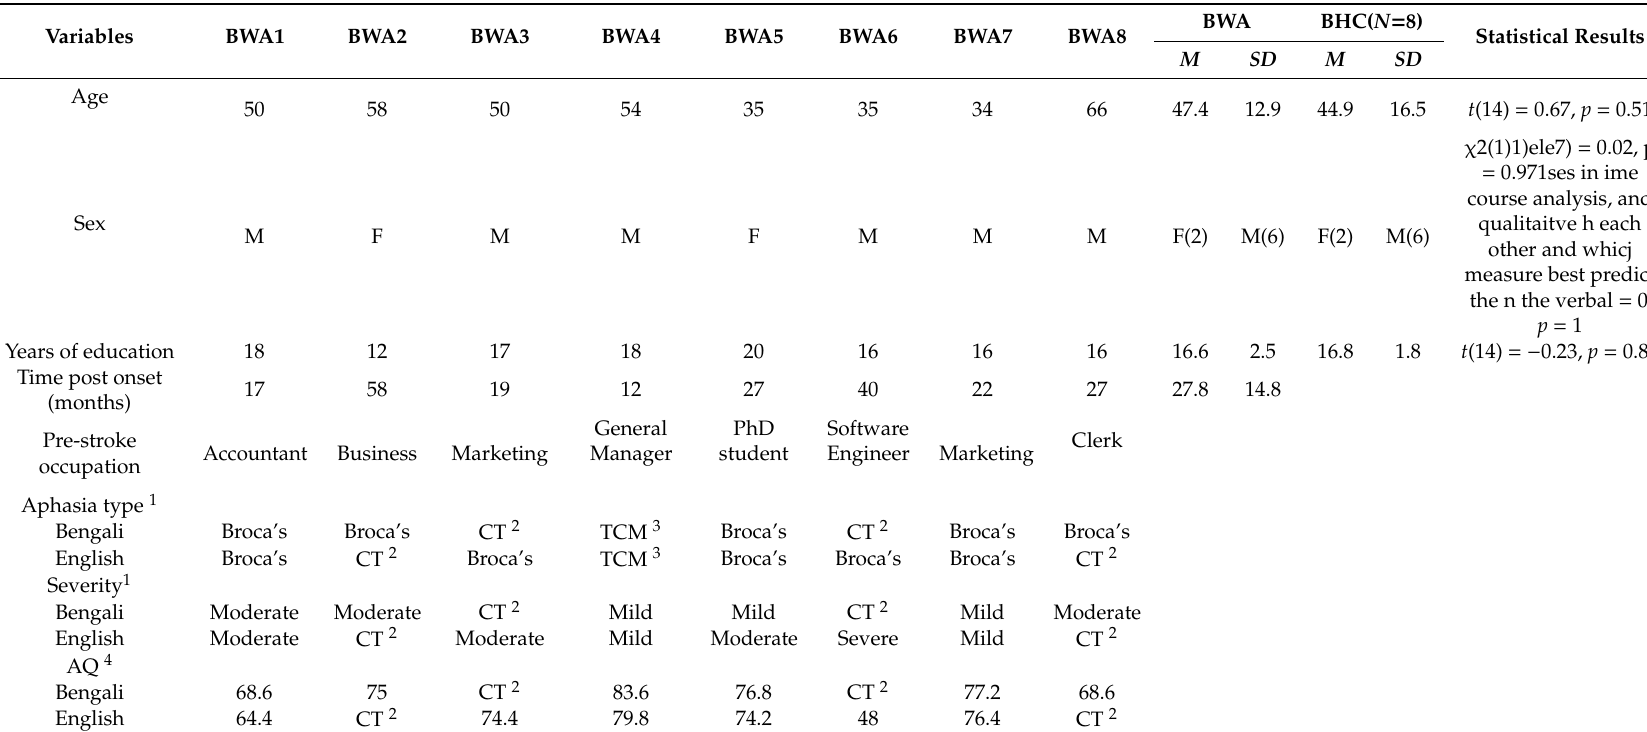
Table 2. Demographic profiles of each BWA, mean and SD of BWA and BHC groups, and the statistical results comparing the